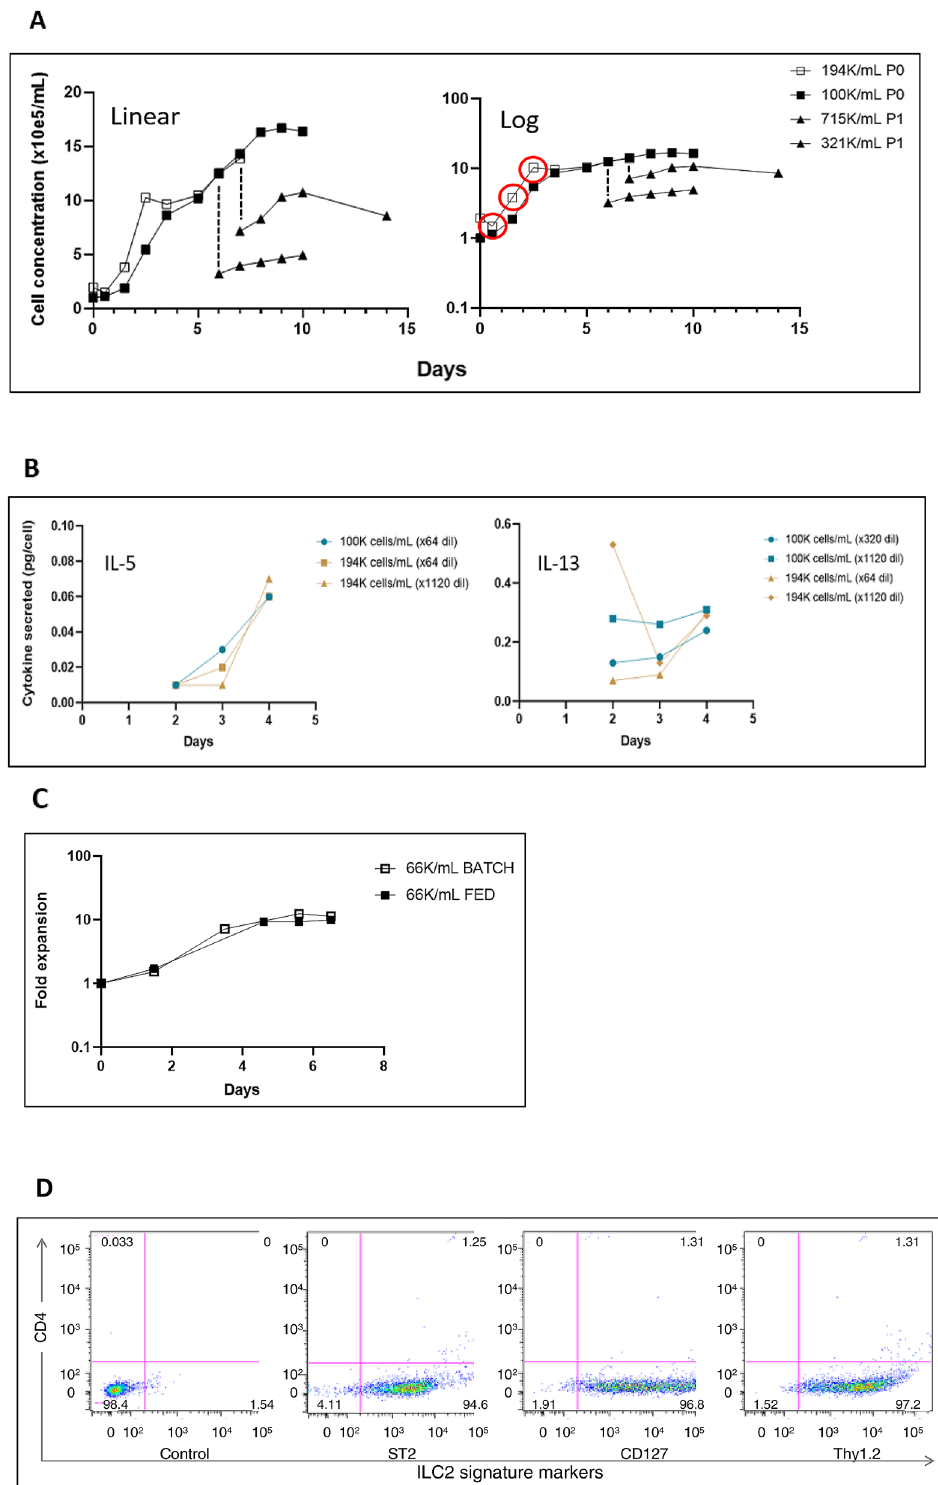
Figure 3. Subcultures of Primary ILC2s using serum-free medium supplemented with IL-33, TSLP, IL-2 and IL-7. ( A ) The starting cell concentration of the original explant (P0) does not have a significant effect on expansion. The three time points highlighted in red represent the exponential phase of cellular growth in the linear and log version of the same growth curve. ILC2 growth rates were calculated during these periods of exponential expansion. ILC2 sub-cultures (P1) at different concentrations seeded on days 6 and 7 after the exponential phase are viable, grow slowly and cells start dying after five days. ( B ) Amount of IL-5 and IL-13 secreted per ILC2 individual cell based on Fig. 3A. We have included two different initial cell concentrations that have been diluted differently in an ELISA assay (not included). ( C ) ILC2 original explants seeded at lower concentrations experience a significant fold expansion in less than 7 days. In addition, changing culture medium every other day (FED) does not have a noticeable impact in expansion compared to batch cultures, where the medium was never changed. ( D ) Cells cultured serum free-media continue to express ILC2-signature-markers after two weeks in